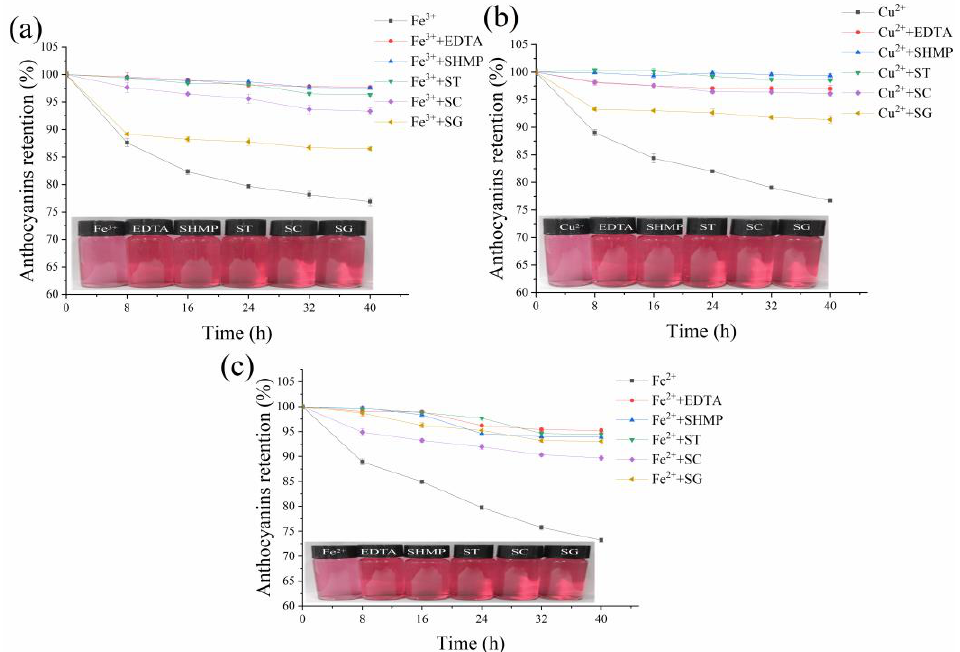
Figure 2. Effects of five chelators, including ethylenediaminetetraacetic acid disodium salt (EDTA), sodium hexametaphosphate (SHMP), sodium tartrate (ST), sodium citrate (SC), and sodium gluconate (SG), on the color stability of the 0.02% ( w/v ) BRA solution against Fe 3+ ( a ), Cu 2+ ( b ), and Fe 2+ ( c ). The insets are the appearances of the fresh BRA solutions containing the corresponding metals and chelators.